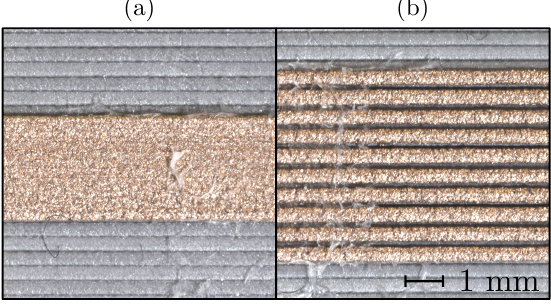
Figure 2. Trace spacing d influence: ( a ) d = 0.25mm, ( b ) d =